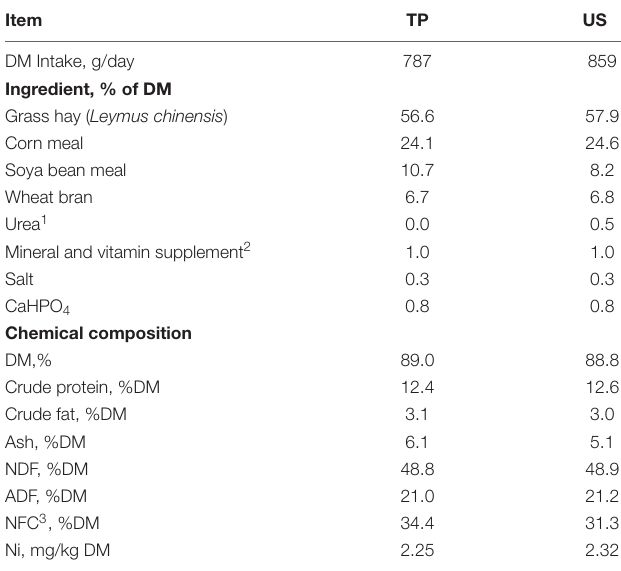
TABLE 1 | Feed intake of goats and composition of experimental